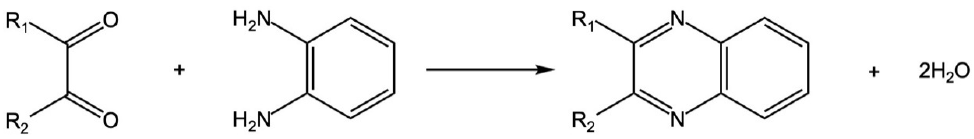
Figure 1. The reaction equation of OPD and α -DCs. Figure 2. The relative contents of phenylacetaldehyde at different steaming times in simulated system 1.